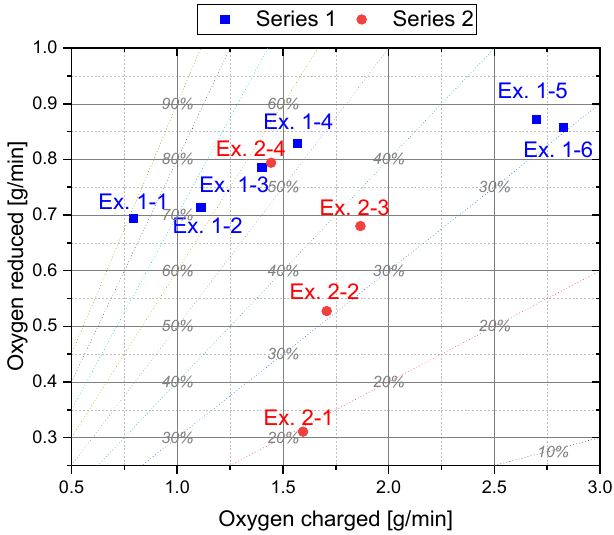
Figure 6. Reduced and charged oxygen during the charging phase (Phase 4).